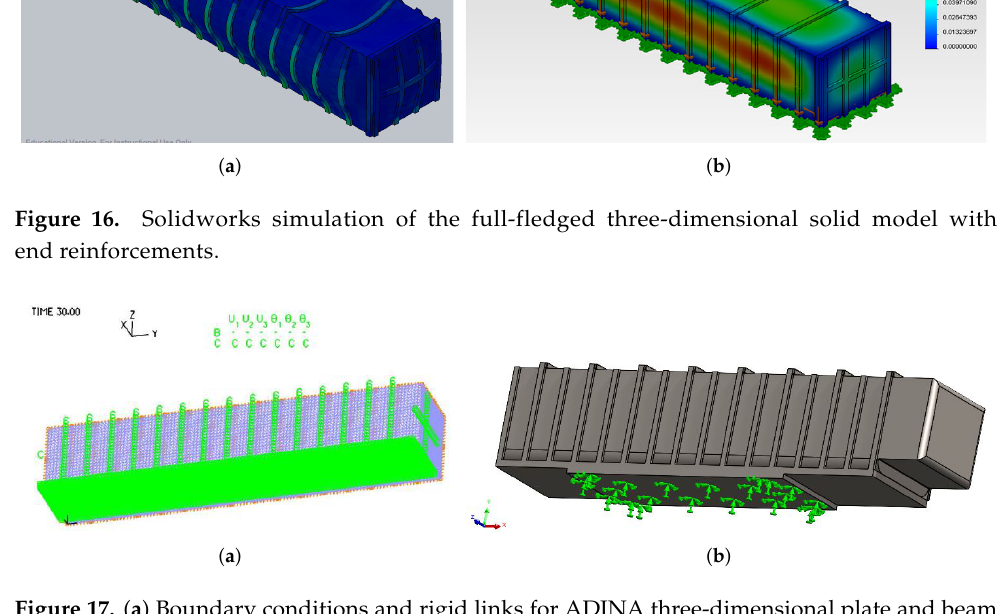
Figure 17. ( a ) Boundary conditions and rigid links for ADINA three-dimensional plate and beam models. ( b ) Boundary conditions for Solidworks three-dimensional solid